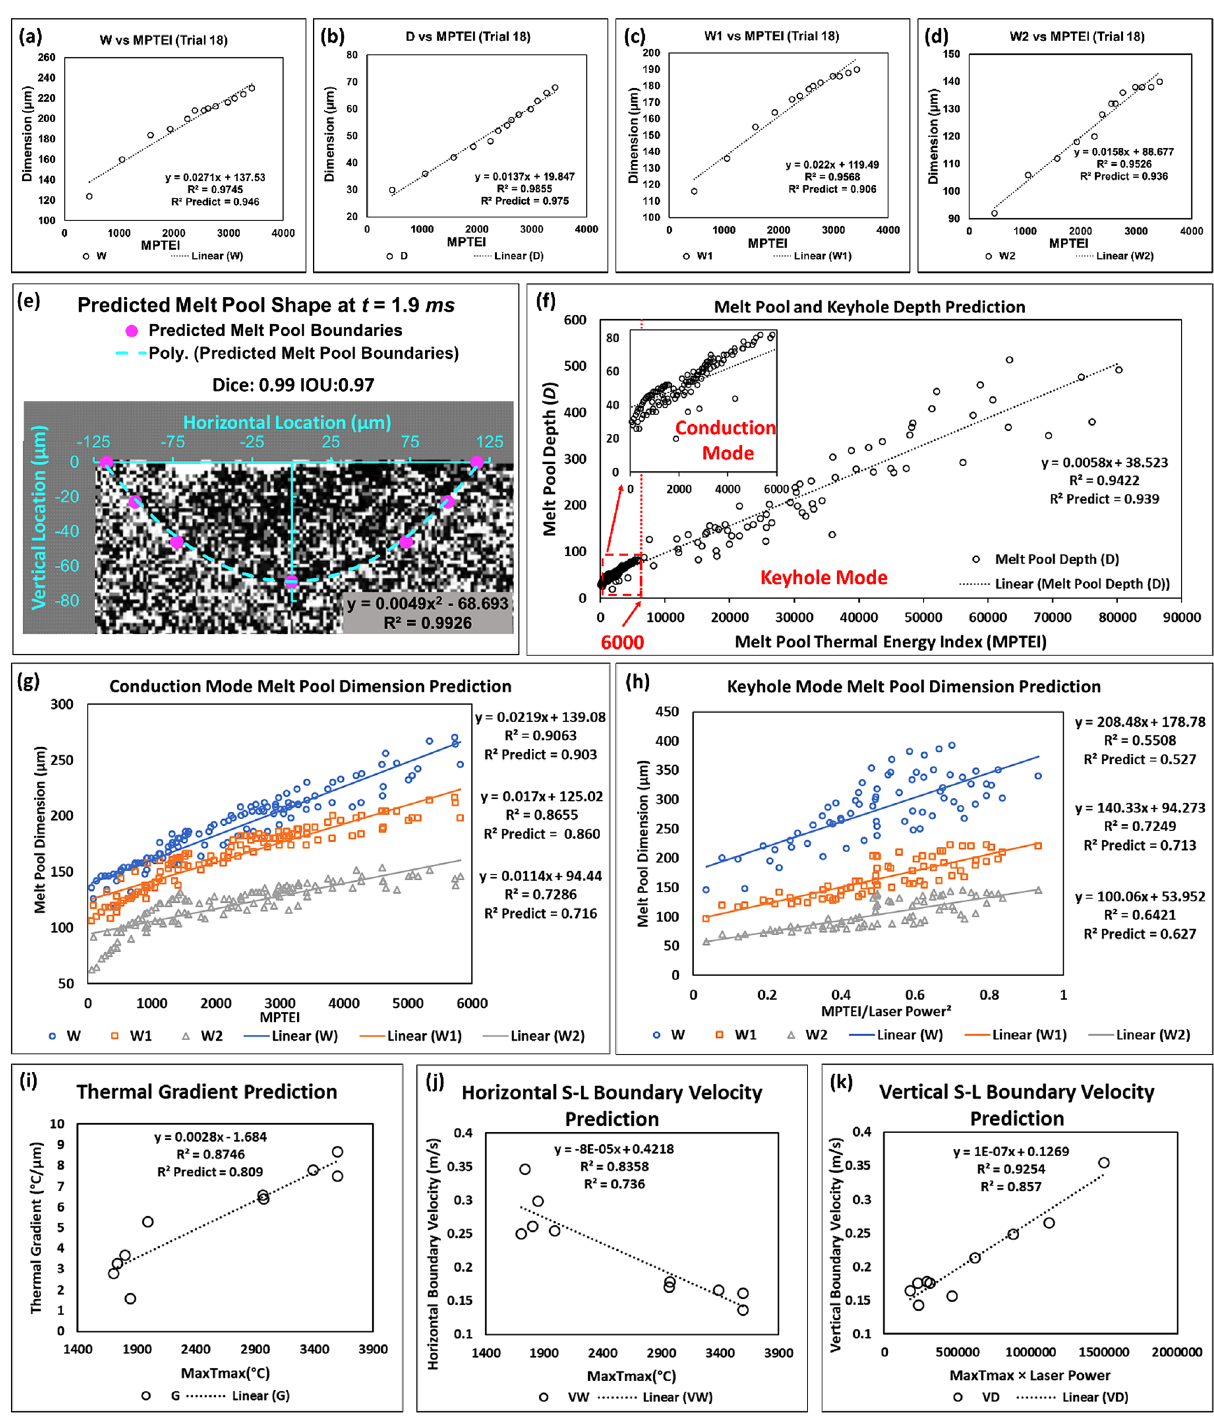
Figure 6. ( a – d ) The relationship between the melt pool dimensions and MPTEI , (Trial #18, Ti–6Al–4V, 156 W, 0.8 ms dwell time). ( e ) The predicted melt pool boundary based on the fitted equations at t = 1.9 ms of Trial #18. ( f ) Melt pool depth prediction based on MPTEI . Notice the melt pool depth is the same as the keyhole depth during keyhole mode. This plot includes all Ti–6Al–4V cases. ( g ) The correlation between W , W 1 , and W 2 with MPTEI for all Ti–6Al–4V cases during conduction mode. ( h ) The correlation between W , W 1 , and W 2 with MPTEI for all Ti–6Al–4V cases during keyhole mode. ( i ) The correlation between thermal gradient and MaxTmax for all Ti–6Al–4V cases. ( j ) The correlation between horizontal solid–liquid boundary velocity ( VW ) and MaxTmax for all Ti–6Al–4V cases. ( k ) The correlation between vertical solid–liquid boundary velocity ( VD ) and MaxTmax · Laser Power for all Ti–6Al–4V